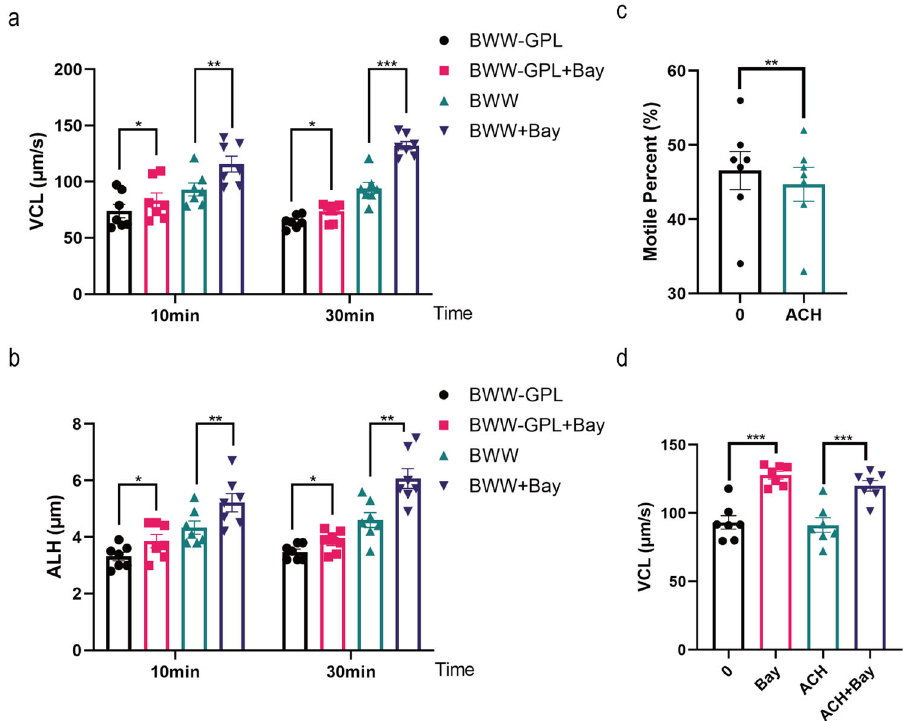
Fig. 5 Bay117082 promotes sperm motility independently of glucose metabolism. a , b Changes in VCL and ALH of sperm treated with 25 μ M Bay117082 in BWW-GPL or BWW media for 10 and 30 mins. BWW-GPL: BWW media lacking glucose (G), pyruvate (P) and lactic acid (L). Values represent mean ± SEM ( n = 7), * p < 0.05, ** p < 0.01, *** p < 0.001, as compared with the corresponding control (0 μ M) in each medium. c Changes in motile percent of sperm incubated with 500 μ M α -chlorohydrin (ACH) for 1 h. Values represent mean ± SEM ( n = 7), ** p < 0.01. d Changes in VCL of sperm treated with 25 μ M Bay117082 in the absence or presence of 500 μ M ACH for 1 h. Values represent mean ± SEM ( n = 7), *** p < 0.001, as compared with the corresponding